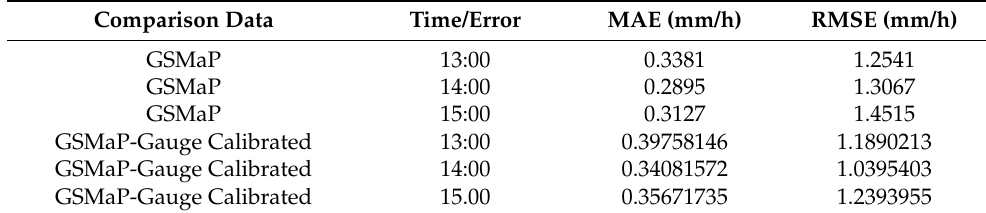
Table 4. Error comparison with GSMaP and GSMaP-Gauge Calibrated rainfall products. Comparison